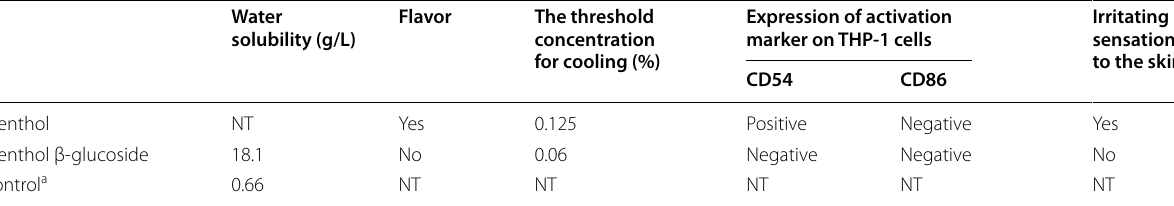
)-menthol β- d -glucoside and ( −